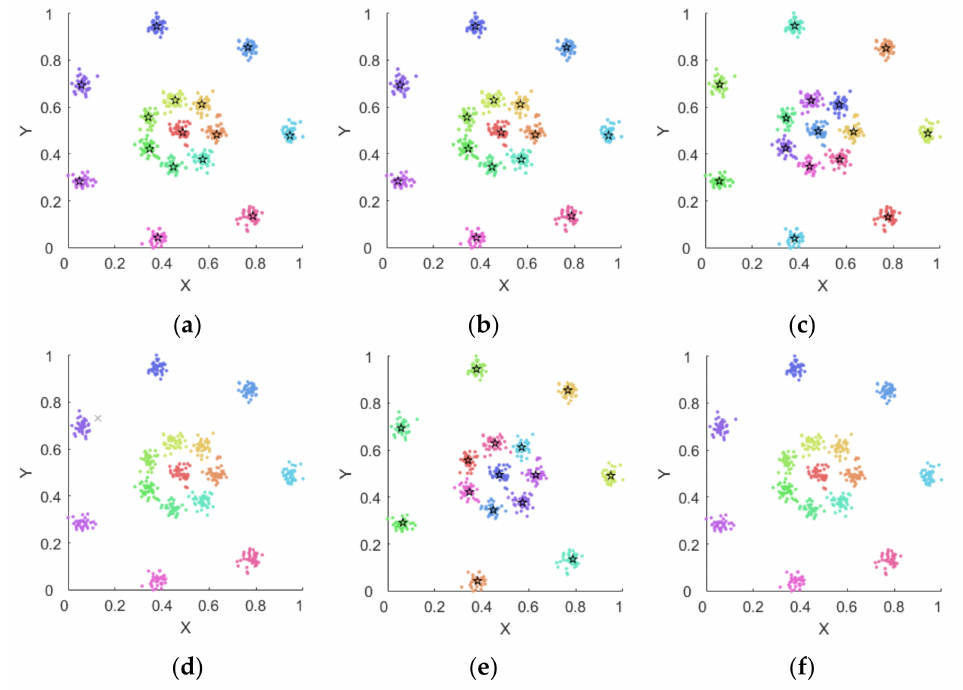
Figure 5. Results on R15. ( a ) ConDPC, ( b ) DPC, ( c ) K-means, ( d ) DBSCAN, ( e ) DPC-DBFN, ( f )